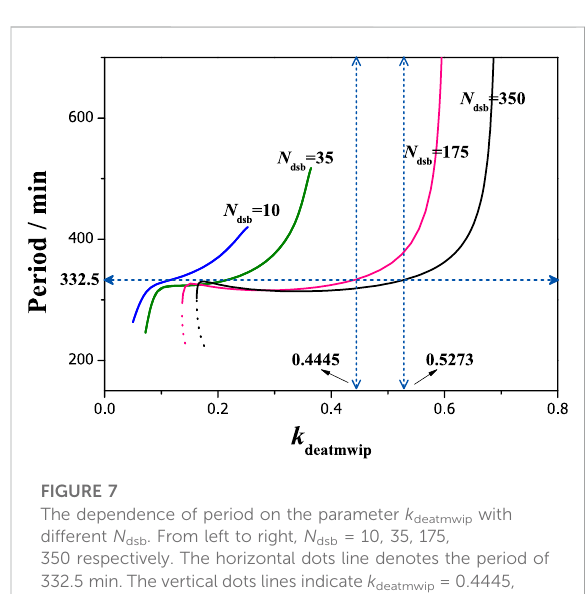
activated. The results in Figure 8 may also provide some theoretical explanation for the experiments of Chen et al [35].